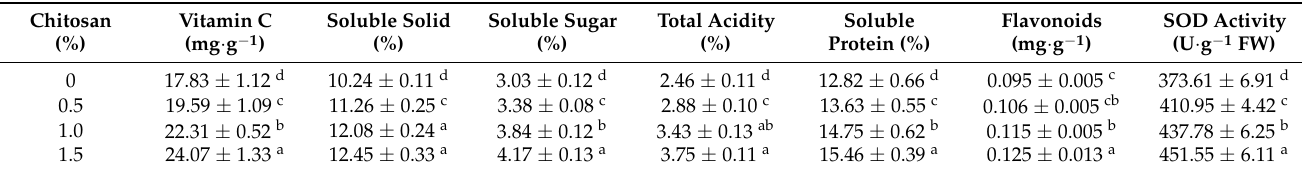
Table 3. The effects of chitosan on quality of R. roxburghii